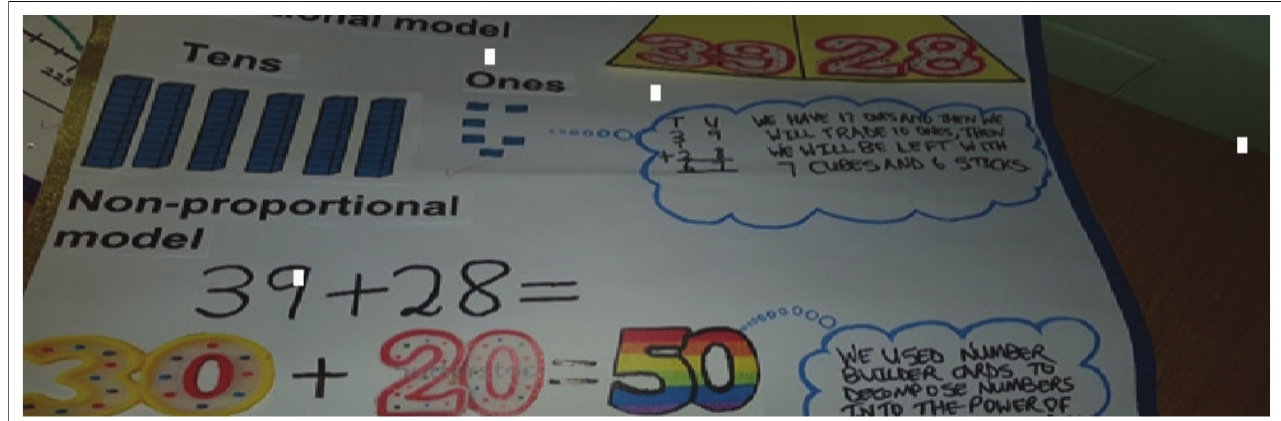
FIGURE 6: Sample of students’ response to item 5.